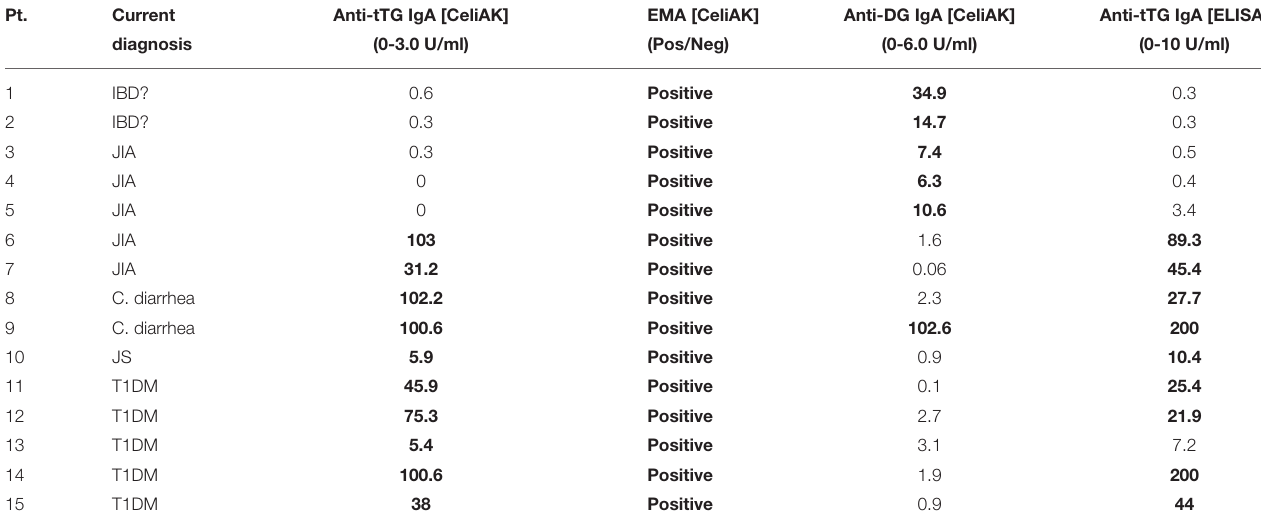
TABLE 2 | CD serological panel of positive patients by CytoBead CeliAK immunoassay (columns 3-4-5) and comparison with the ELISA results (columns 6). Pt.